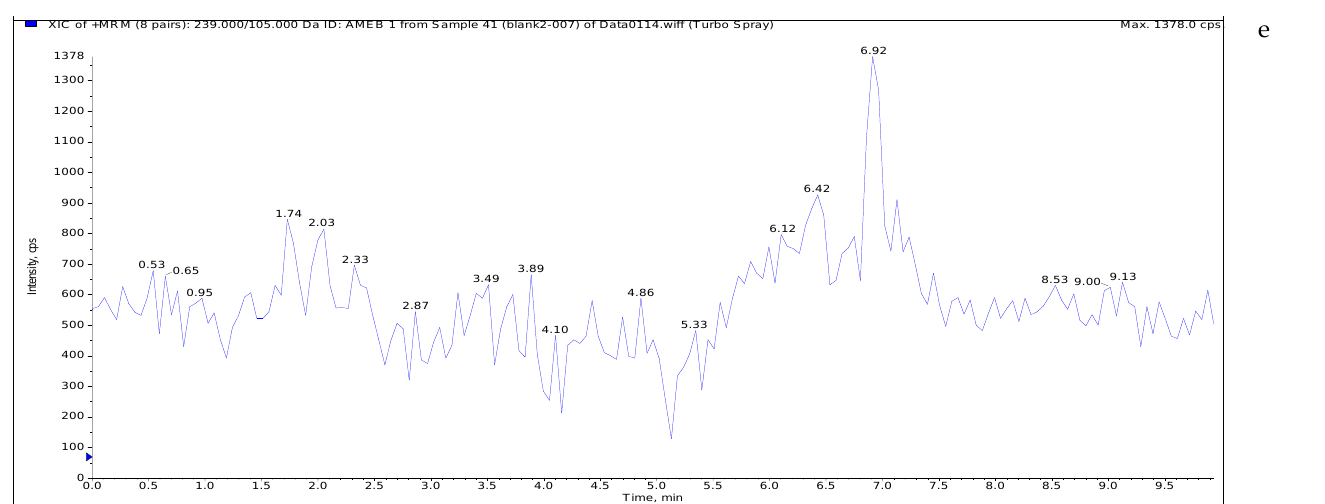
Figure 4. Total ion chromatograms and extracted ion chromatograms of blank hen whole egg samples. ((a) Total ion chromatogram; (b) extracted ion chromatogram of LMS; (c) extracted ion chromatogram of MBZ; (d) extracted ion chromatogram of HMBZ; (e) extracted ion chromatogram of AMBZ).